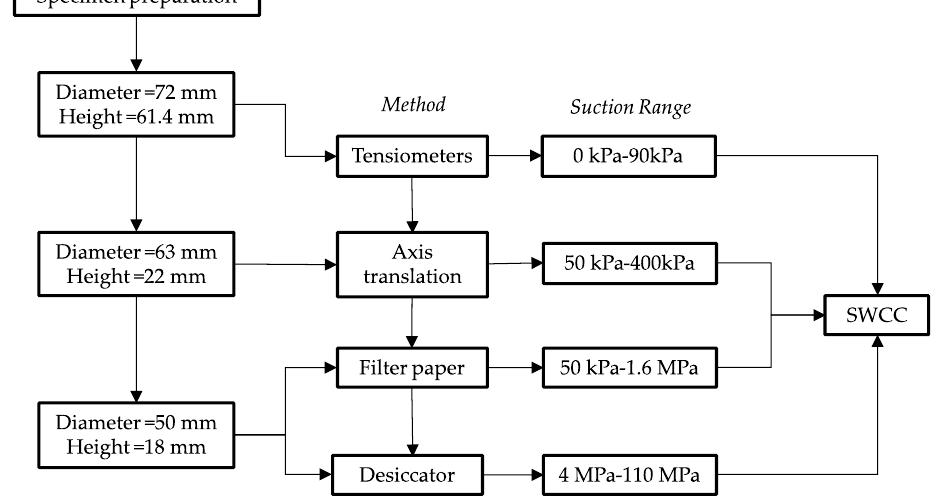
Figure 6. Combination of methods to obtain